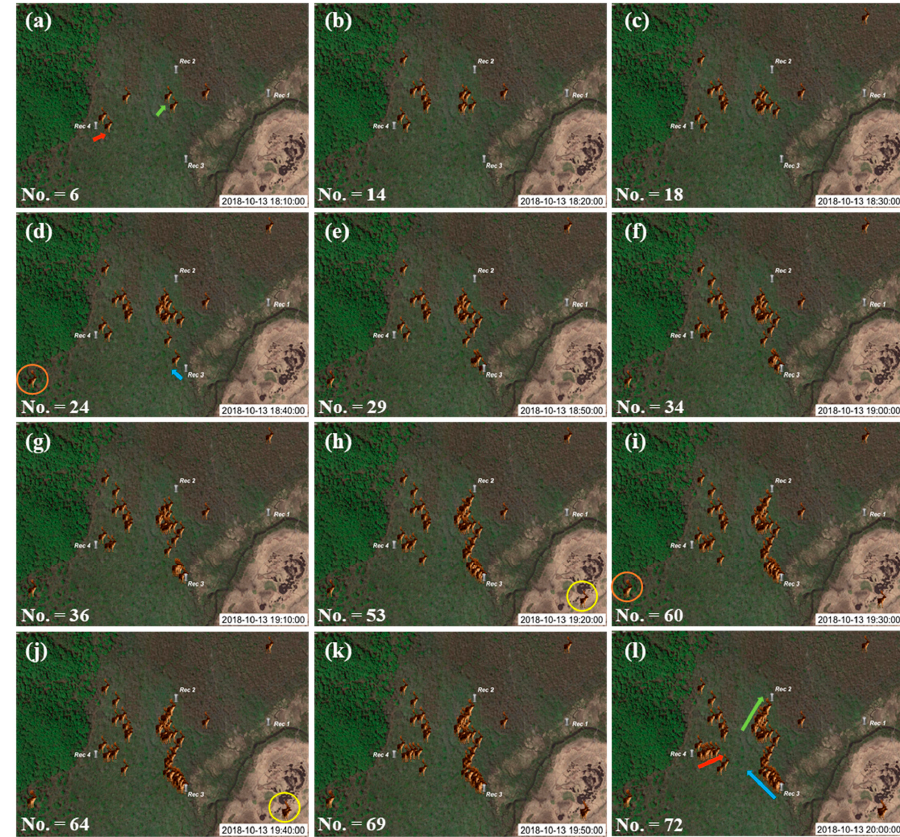
Figure 9. Images show the accumulation of deer call positions from starting time (8:00:00 on 13 October 2018) at 10 min interval for 2 h, as shown in ( a – l ). Deer symbols represent the position of deer calls retrieved by the proposed technique. Yellow and orange circles highlight the occurrence of deer calls from the same deer at two different times. The green, red, and blue arrows highlight the repetition and potential path of the same deer with multiple calls. The No. in each figure represents the total accumulated deer calls from the starting time (18:00 on 13 October 2018). trap 1. Camera trap 1 captured a male deer at 19:30:46 (Figure 10b). The positions of four deer calls retrieved using the proposed technique were within 50 m from camera trap 2 between 18:11:26 and 18:53:45 (the orange circle in Figure 10a). Camera trap 2 captured male deer at 18:15:02 (Figure 10c). As both images of the camera traps are for male deer